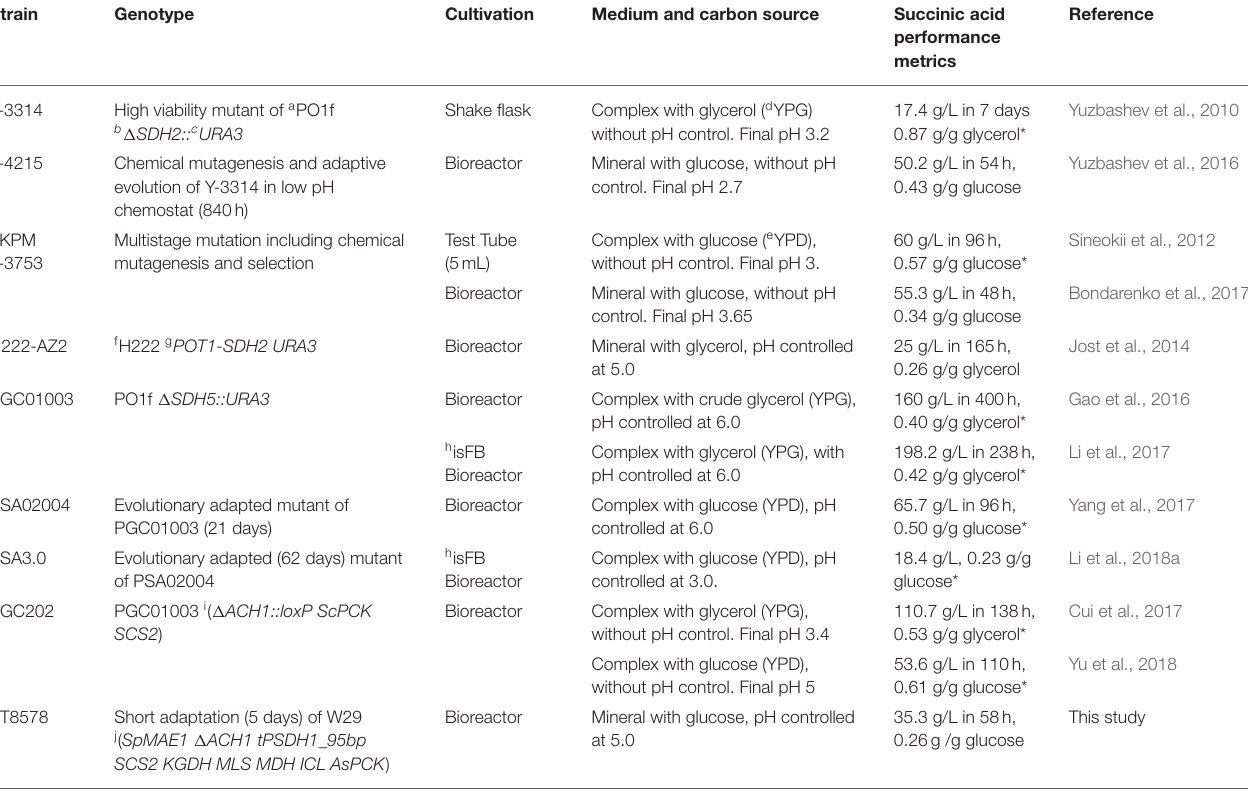
TABLE 1 | Overview of production of succinic acid by Yarrowia lipolytica .